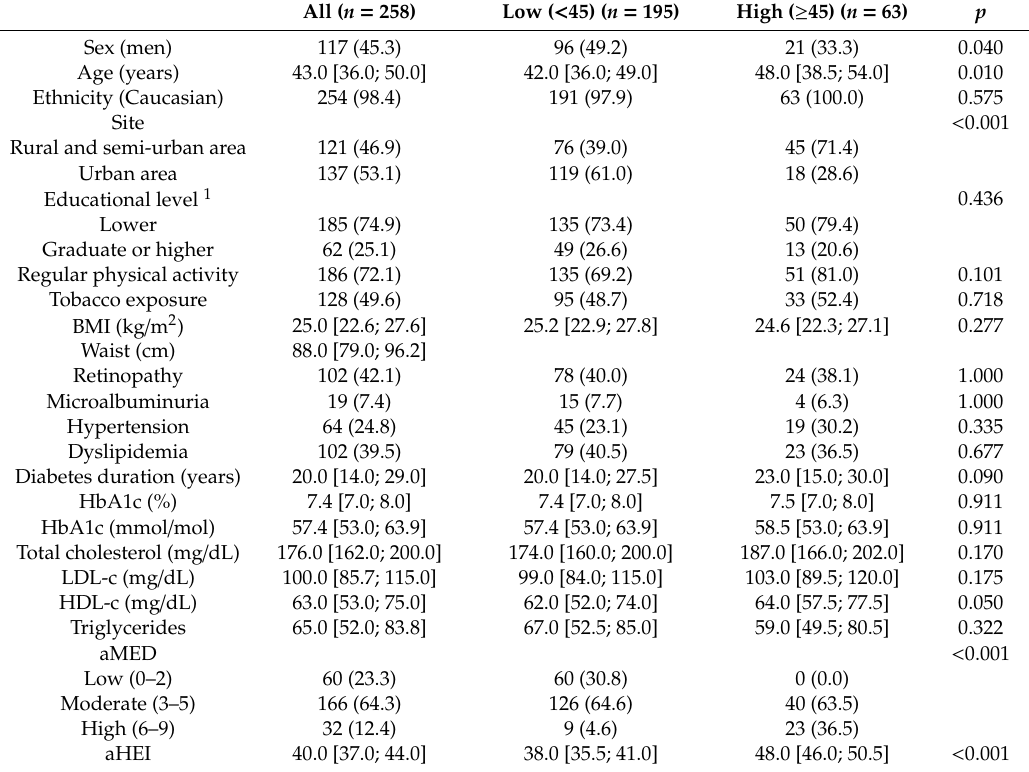
Table 2. Descriptive analysis of the characteristics of the study participants according to the alternate Healthy Eating Index.